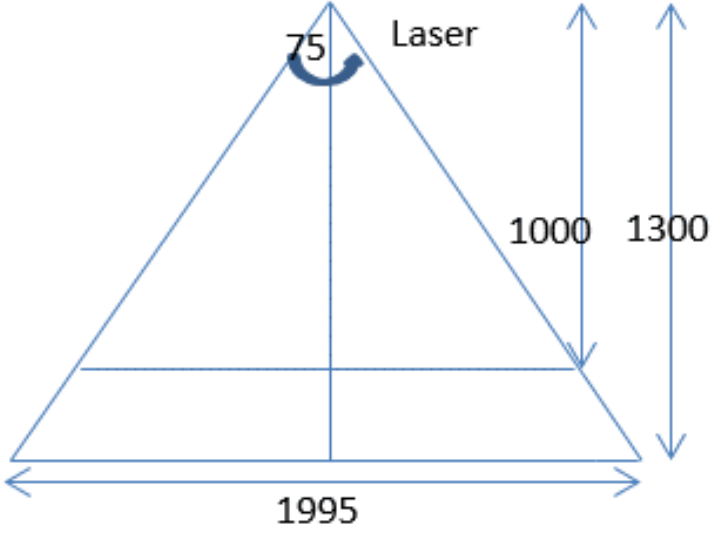
Figure 7. Structure Diagram.